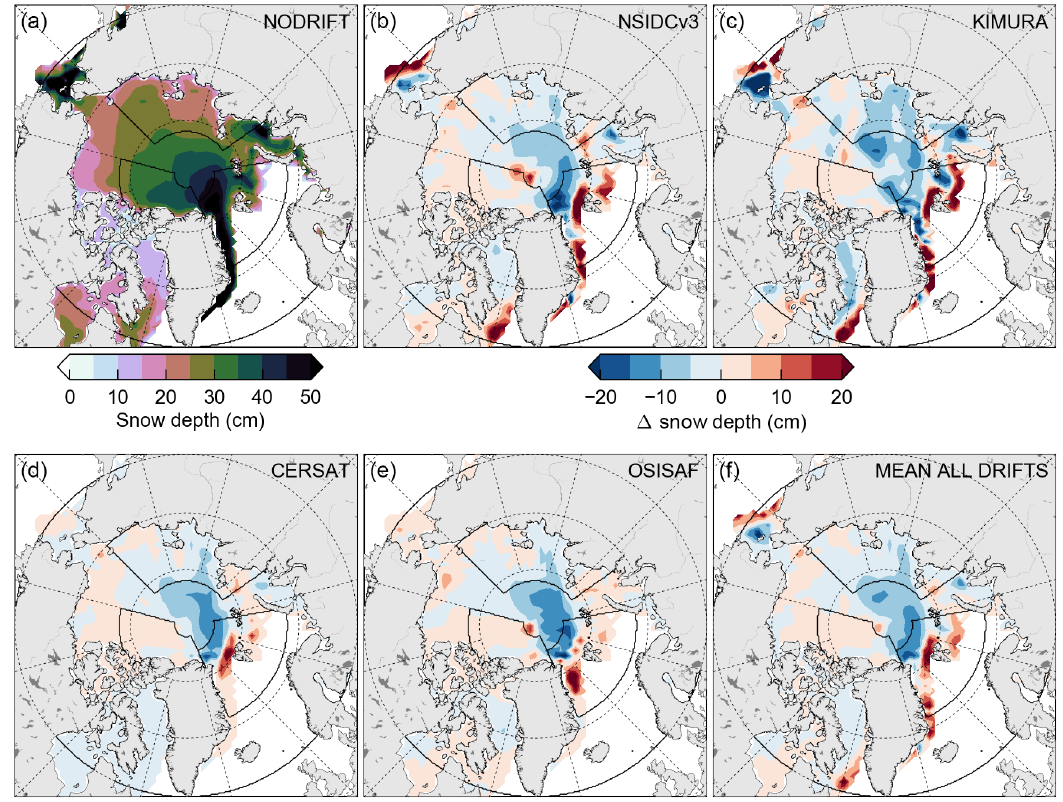
Figure 12. Modeled snow depth on 1 May (averaged over 1 May 2011, 2013, 2014 and 2015), assuming no ice motion (NODRIFT, a ) and then the difference to the simulations forced by the four different ice motion products and the mean snow depth from the four different forced model